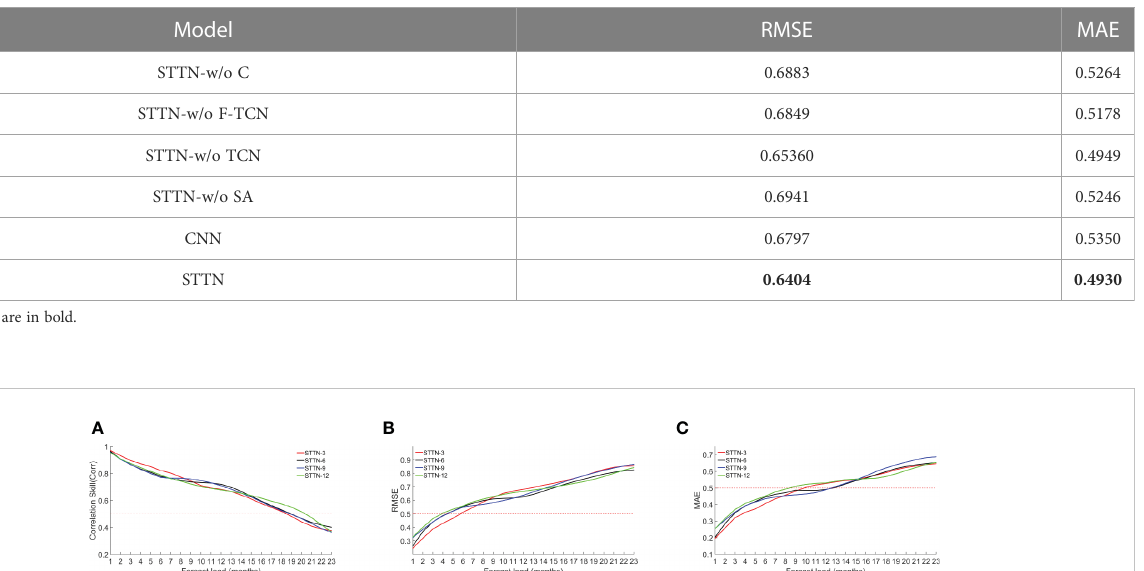
TABLE 6 The RMSE and MAE between Niño3.4 index predictions and observations obtained using different modules and the CNN model.